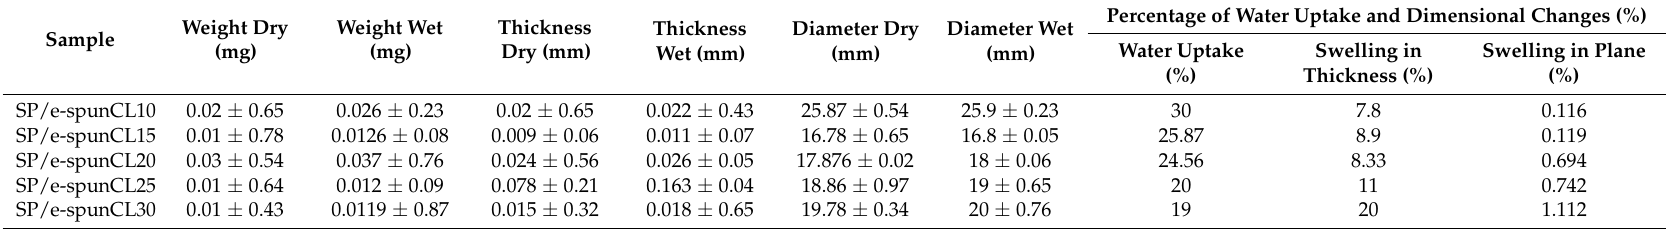
Table 5. Swelling properties of SPEEK and its corresponding nanocomposite membranes with various DS in